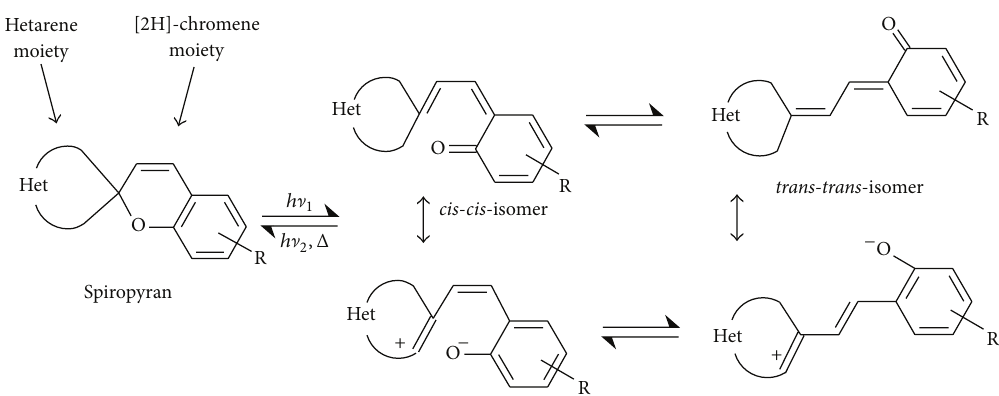
Figure 1: General scheme of photoisomerization for spiropyran-like